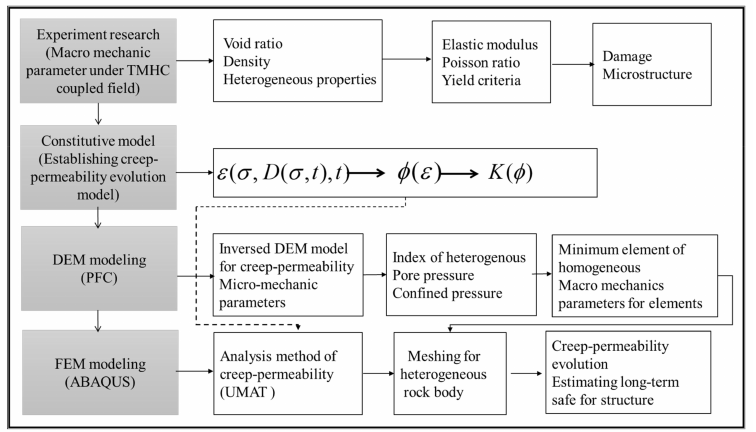
Figure 2. Algorithm and task for the investigation of the creep-permeability